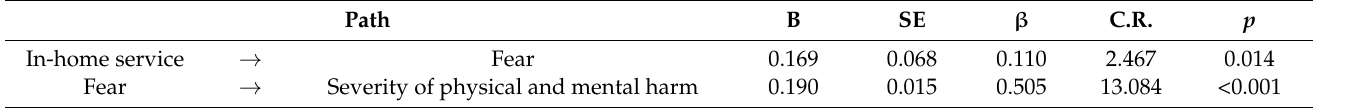
Table 2. Results of path